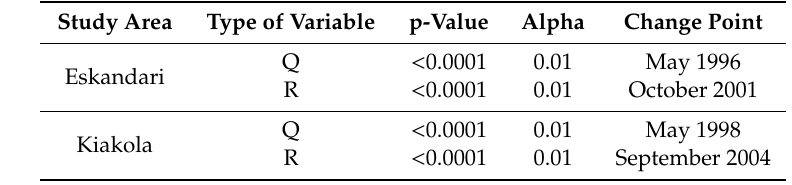
Table 2. Change point detection using Pettit’s test.